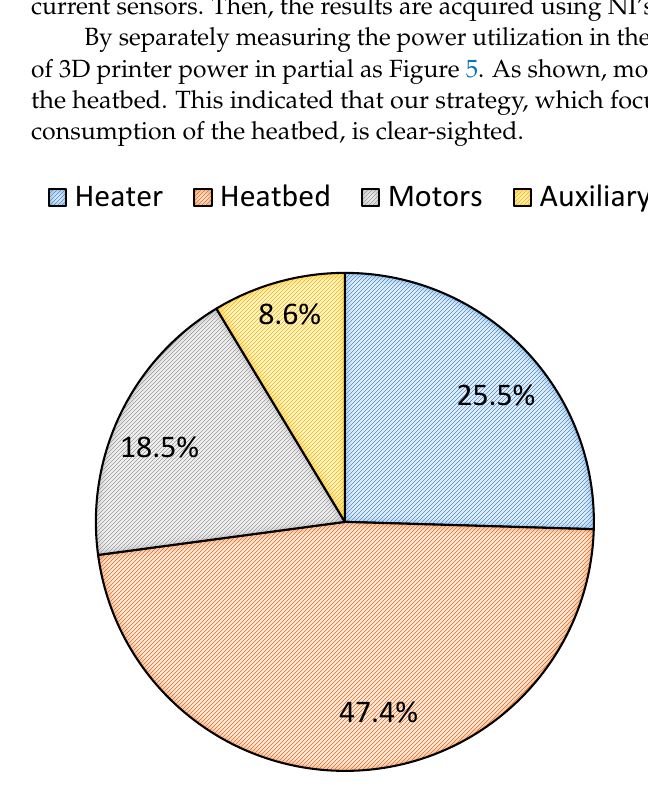
Figure 5. The distribution of 3D printer power in partial.